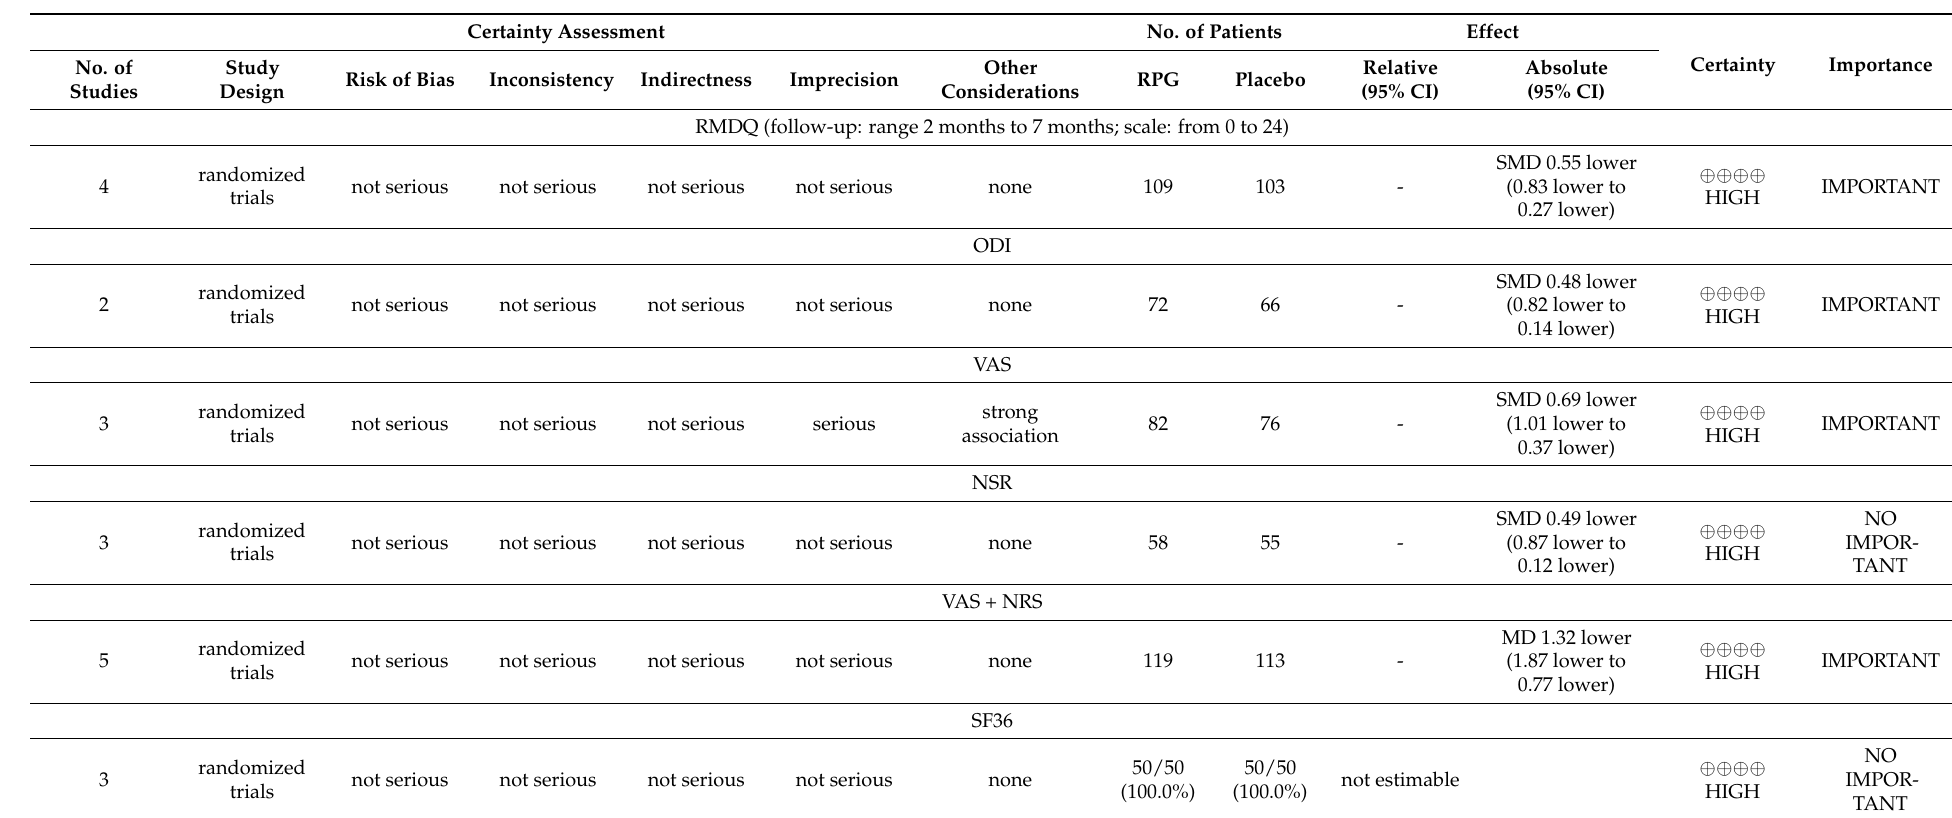
Table 4. Quality of the